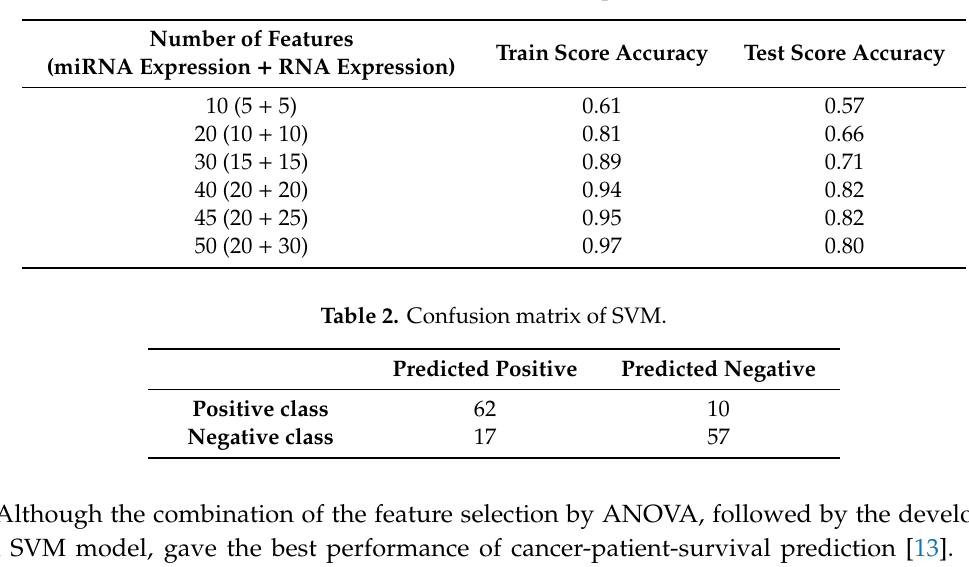
Table 1. Evaluation of SVM model performance.